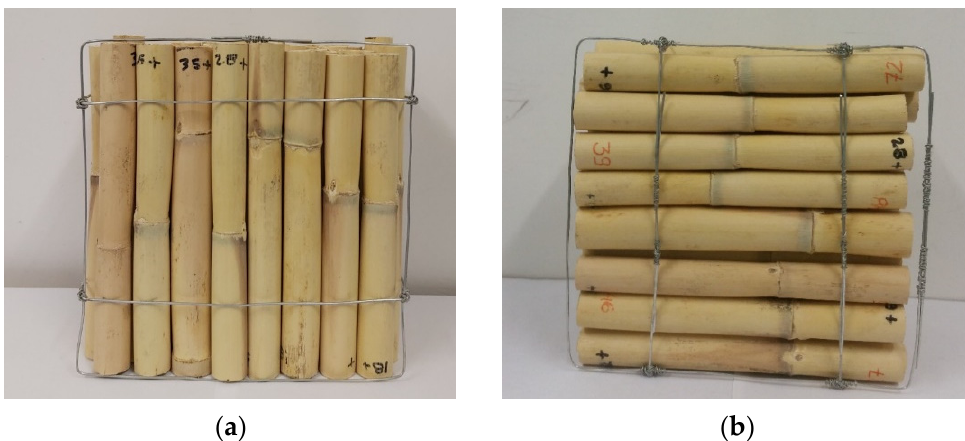
Figure 9. Irregularities from giant reed stalks.